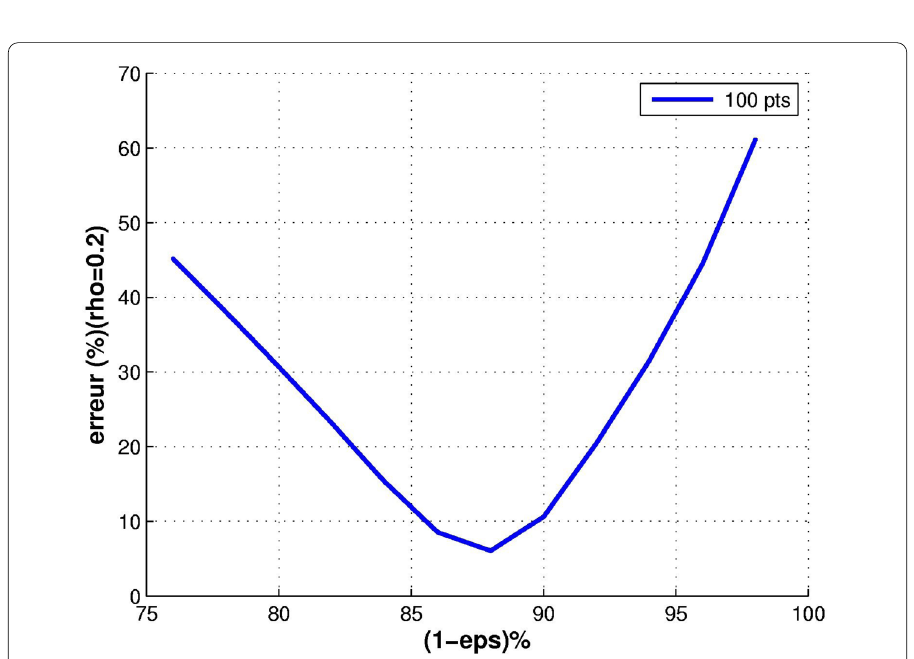
Figure 4 Variation of the error function